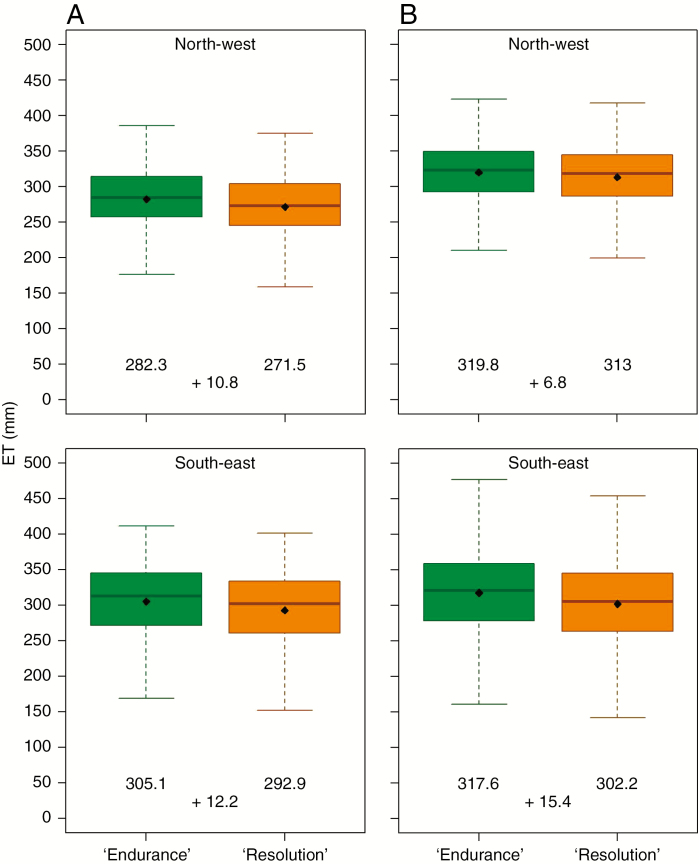
Cumulative simulated ET from October in the previous year to September for SRC willow cultivars ‘Endurance’ (green) and ‘Resolution (orange) and a 2-year growth cycle management in the NW (top) and SE (bottom) of the UK (two weather stations and 17 soils per region) between 1966 and 1988 (baseline, A) and 1991 and 2013 (recent, B). Averages are represented by a black dot; under each boxplot is shown their values and the differences between ‘Endurance’ and ‘Resolution’ means are shown between them. The bottom and the top of the box represent the first (Q1) and third (Q3) quartiles, respectively, and the median is represented by the thick line inside the box. The lower and upper whiskers equal Q1 − 1.5 × (Q3 − Q1) and Q3 + 1.5 × (Q3 − Q1), respectively.